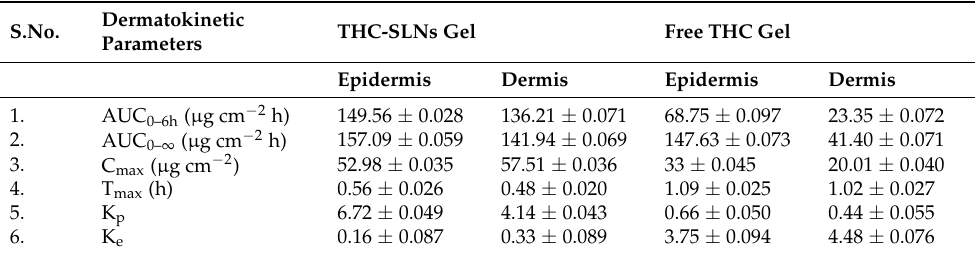
Table 3. Various dermatokinetic parameters from concentration time profiles in the epidermises and dermises of Wistar rats after treatment with THC-SLN gel and free THC gel. S.No.